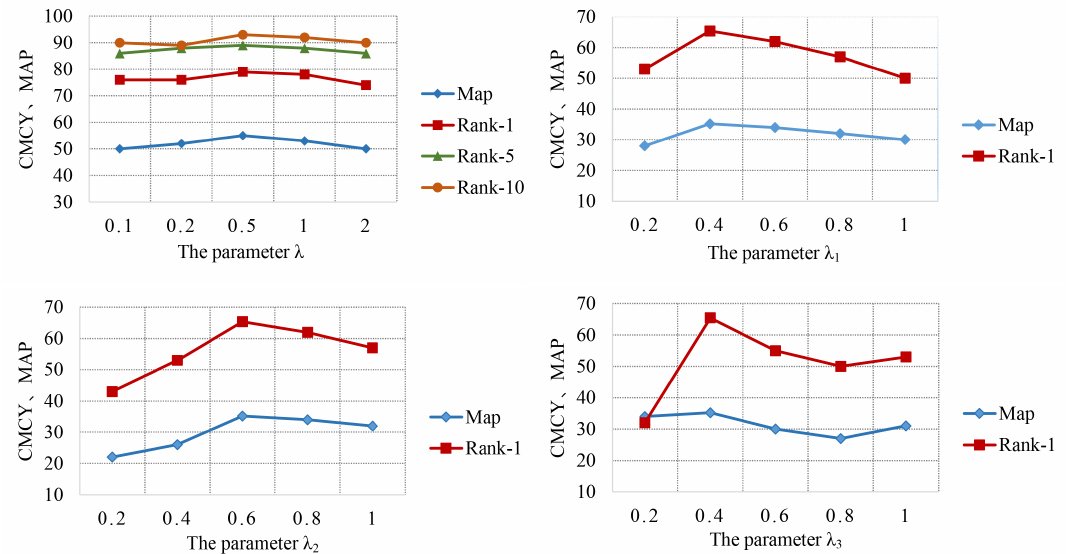
Figure 8. Analysis of parameters λ in Eq.10 and λ 1 , λ 2 , λ 3 in Eq.6